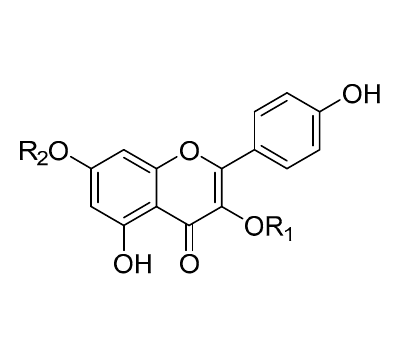
Figure 3. Chemical structures of compounds 1 – 9 .